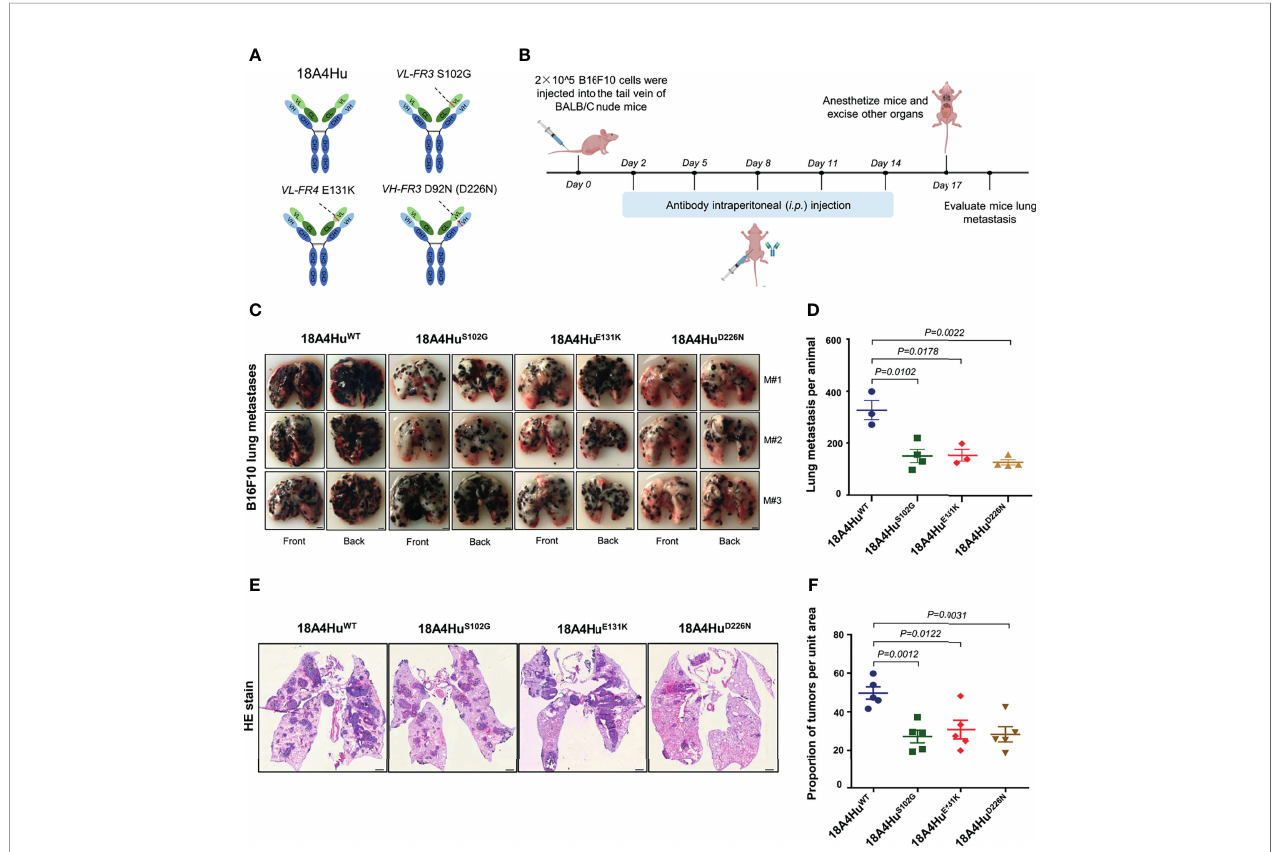
FIGURE 4 | 18A4Hu variants inhibit tumor metastasis in the lungs of BALB/c nude mice. (A) Three scFv mutants (S102G, E131K, or D226N) were placed back to the human IgG backbone. (B) Schematic illustration of the treatment design. BALB/c nude mice were implanted with 5 × 10 5 per mouse B16F10 tumor cells. Day 2 after injection, mice were treated with the antibody 18A4Hu and its variants by intraperitoneal (i.p.) injection (100 mg per kg in 200 m l 1 × PBS) one for every three days for fi ve times. (C, D) Representative macroscopic images (C) of lungs from 18A4Hu- and variant-treated animals to quantify lung metastases (D) after i.v. engraftment of B16F10 cells. (E, F) Representative macroscopic images of H&E staining in lung (E) and quanti fi cation of metastatic pulmonary metastasis nodules (F) from 18A4Hu- and variant-treated animals. Data are represented as the mean ± s.e.m. of n = 3/4 mice (D) , n = 5 (F) . p values calculated with unpaired Student ’ s t-test (D, F) . Scale bar, 2 mm (F) , or 1 mm (F)